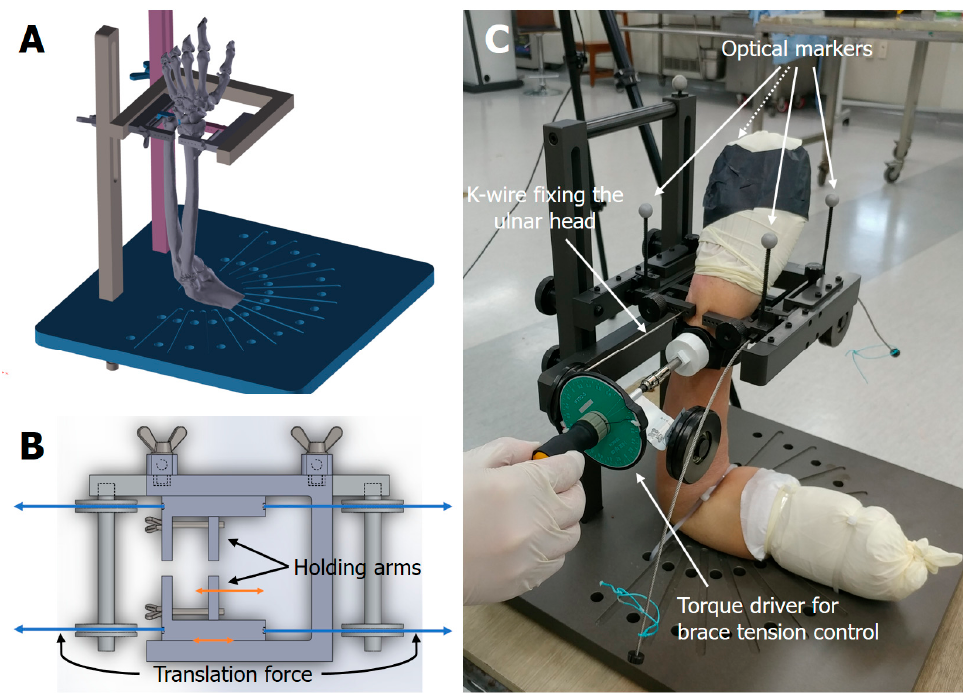
Figure 2. Customized testing system. ( A ) Scheme in 3D of the testing jig. The jig was designed to simulate a DRUJ ballottement test. ( B ) Structure of the holding tool arms. The translation force on the radius was applied through the string attached to the sliding part of the holding tool arms. ( C ) Actual test setting. The ulna was fixed with a K-wire, and the DRUJ translation was measured by detecting the motion of the radial optical markers in a volar–dorsal direction. The external wrist band brace was tensioned uniformly with a torque driver.